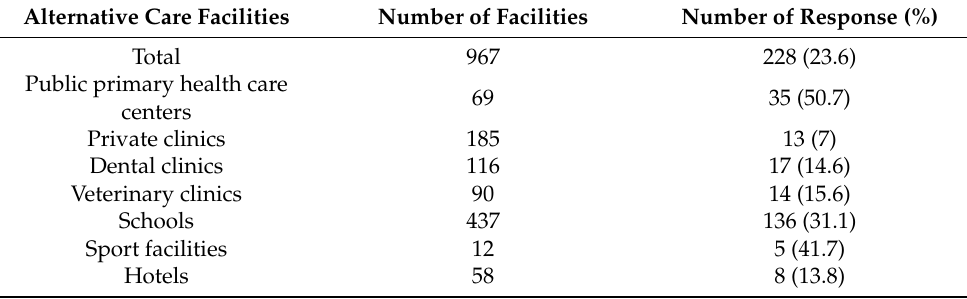
Table 1. The response rate of all ACFs in